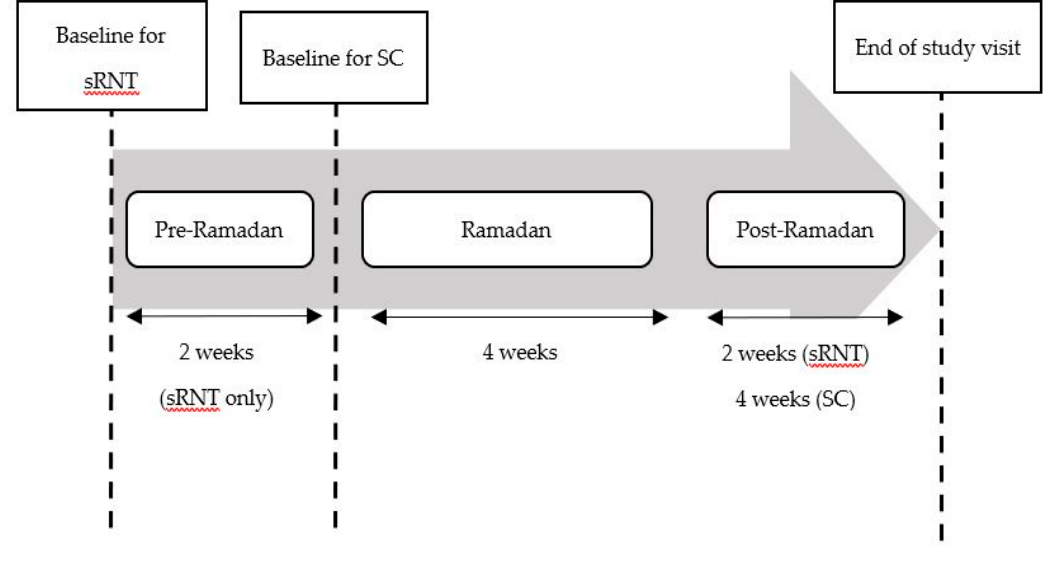
Figure 1. Study Figure 1. Study design.